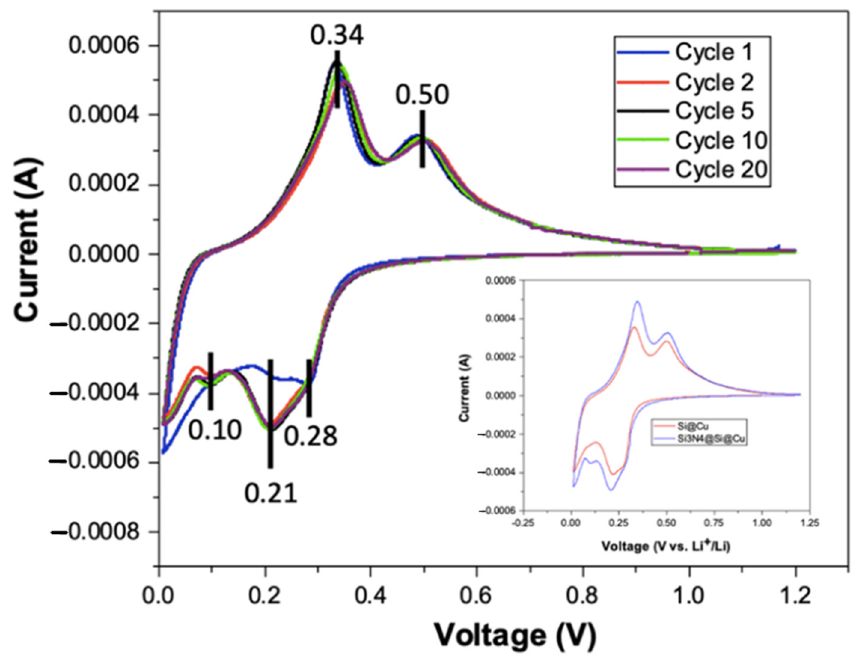
Figure 8. Cyclic voltammograms of Si 3 N 4 @Si@Cu anode in half cell vs. Li + /Li. Graphical inset fea- tures the first CV of Si 3 N 4 @Si@Cu compared with Si@Cu film. features the first CV of Si 3 N 4 @Si@Cu compared with Si@Cu film.